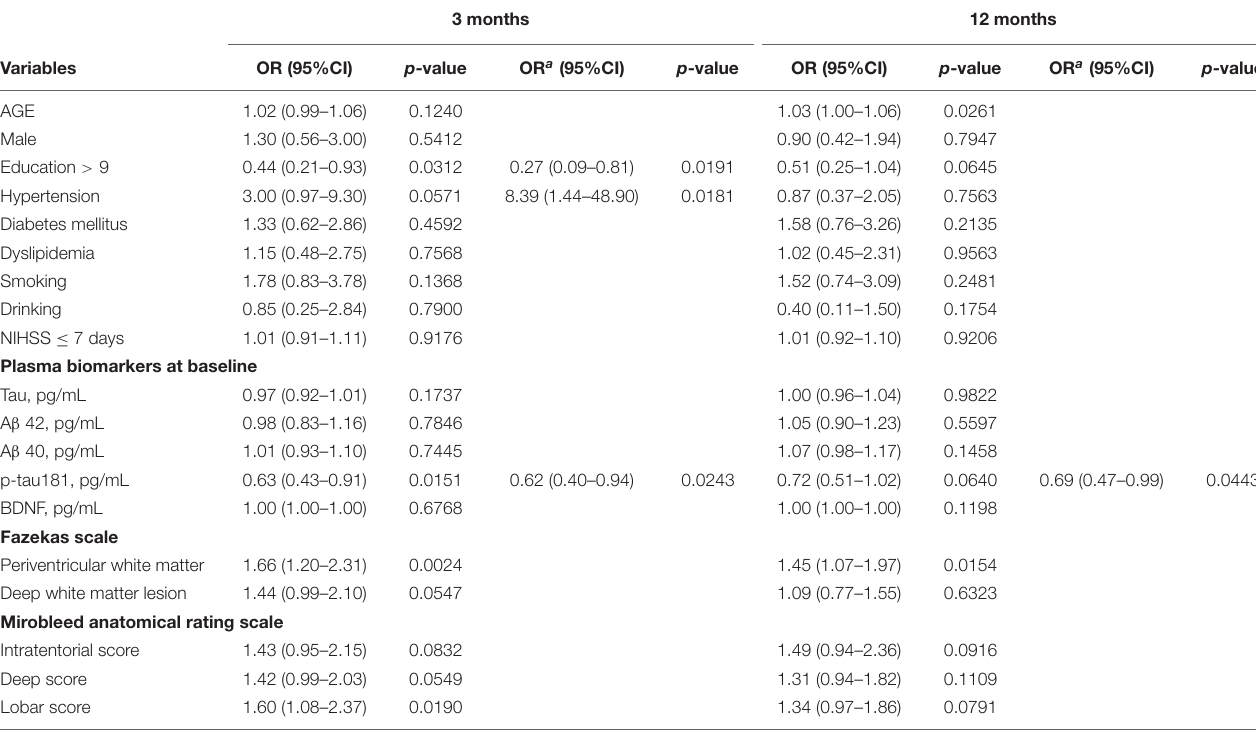
TABLE 2 | Univariate and multivariate logistic regression analyses for patients with PSCI and without PSCI at 3 and 12 months, respectively. 3 months 12 months